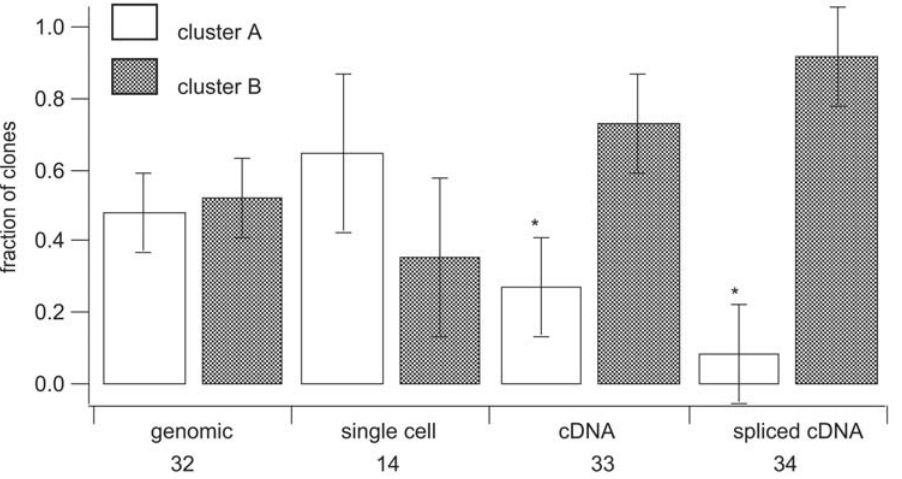
Figure 5. The sorting of different actin clones between the two clusters of copies. The different cluster assignments for genomic culture DNA, single cell genomic, and two different cDNA amplicons (see Figure 3 for arrangement) are shown, asterisks indicate significant differences at p , 0.05. Below each category the total number of clones sequenced is given. The cluster A and B assignments refer to the location of the clones on figure 3.